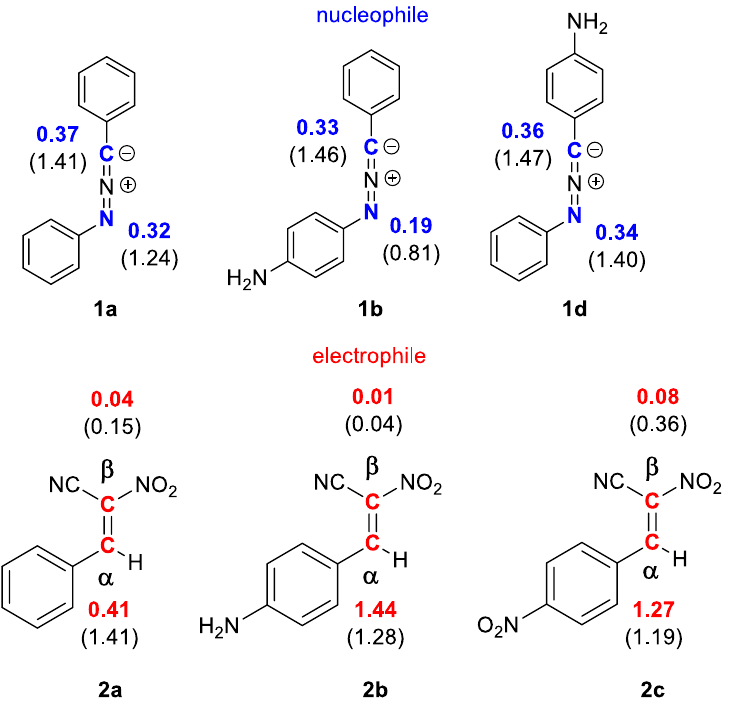
Figure 1. The local electronic properties of nitrylimines 1a,c,e and nitroethanes 2a – c . The nucleo- philic P k − given in blue and the electrophilic P k+ given in red; the indexes of local nucleophilicity N k and local electrophilicity ω k given in brackets. local electrophilicity ω k given in